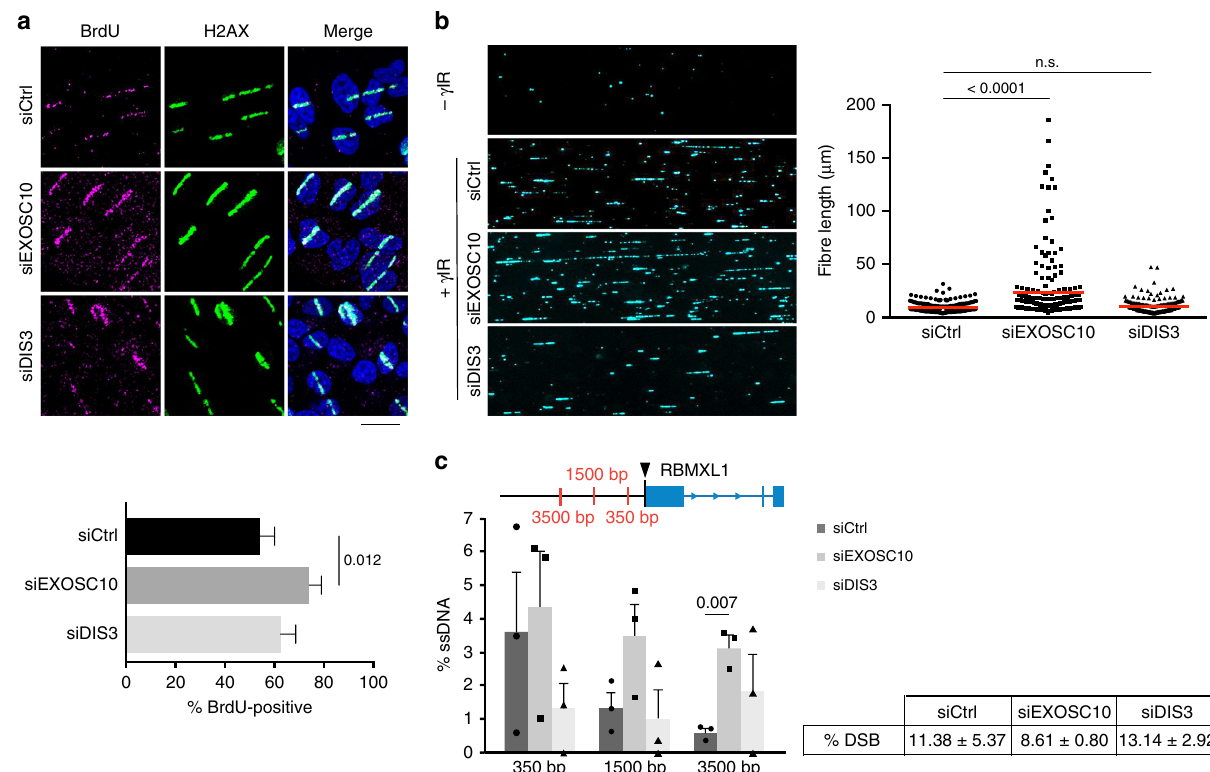
Fig. 3 EXOSC10 is necessary for limited DNA end resection. a HeLa cells were depleted of either EXOSC10 or DIS3, cultivated in the presence of BrdU for 24 h, UV micro-irradiated and fi xed for immuno fl uorescence 10 min after irradiation. The bar plot shows the percentage of γ H2AX-positive stripes that were co-stained by an anti-BrdU antibody. Error bars represent s.e.m. ( n > 60 cells for each siRNA treatment, from at least two independent experiments). Statistical testing was done using a Mann – Whitney ’ s test and signi fi cant p -values are shown in the fi gure. The scale bar represents 20 μ m. b The image shows single-strand DNA tracks (SMART) analysed in U2OS cells 48 h after transfection with siCtrl, siEXOSC10 or siDIS3. The graph shows fi bre length quanti fi cations of one out of three biological replicates with n = 200 cells analysed. Statistical testing was done using a Mann – Whitney ’ s test and signi fi cant p -values are shown in the fi gure. c DIvA cells were transfected with either siCtrl, siEXOSC10 or siDIS3 for 48 h and treated with 300 nM 4-OHT for 4 h before extracting the genomic DNA for analysis of DNA end resection. ssDNA levels were measured by qPCR at three positions upstream of the AsiSI cleavage site ( arrowhead ). The non-DSB background levels were subtracted and the corrected ssDNA values are shown in the histogram. The error bars represent s.e.m. from three independent experiments. Statistical testing was done using a paired Student ’ s t -test ( n = 3) and signi fi cant p -values are shown in the fi gure. The percentage of DSBs produced in each condition is shown in the fi gure. Source data for Fig. 3a – c are provided as a Source Data fi